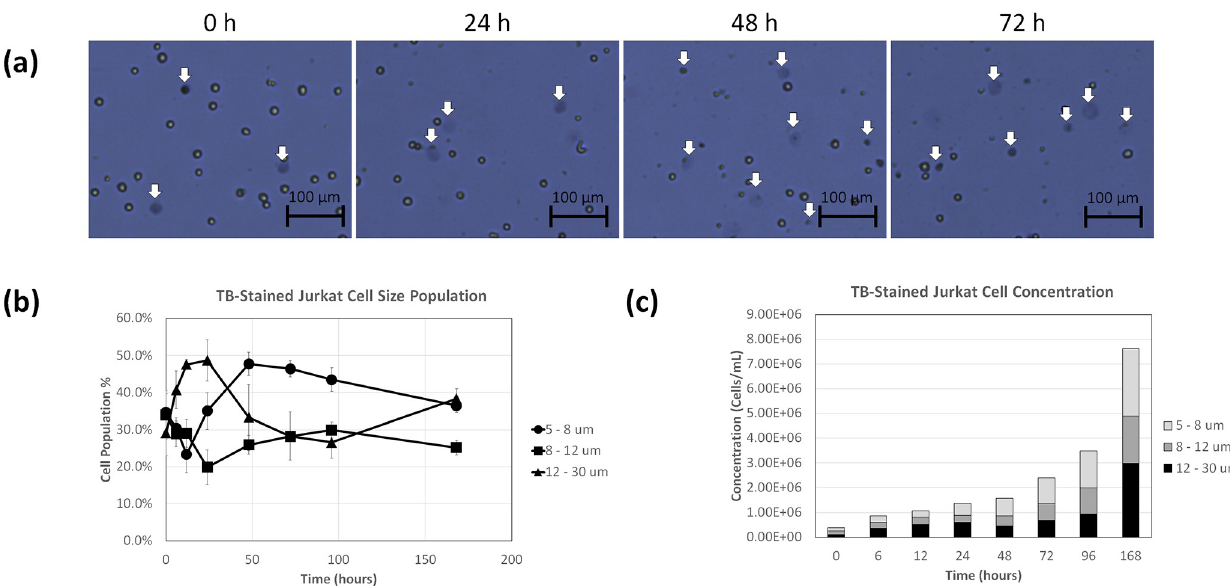
Fig 4. Time-course morphological analysis of TB-stained Jurkat cells. (a) Bright field images of TB-stained Jurkat cells acquired by the AutoT4 showing diffuse objects. (b) Time-dependent size populations over 168 h, showing increase in diffuse objects. (c) Concentration changes for different size populations over